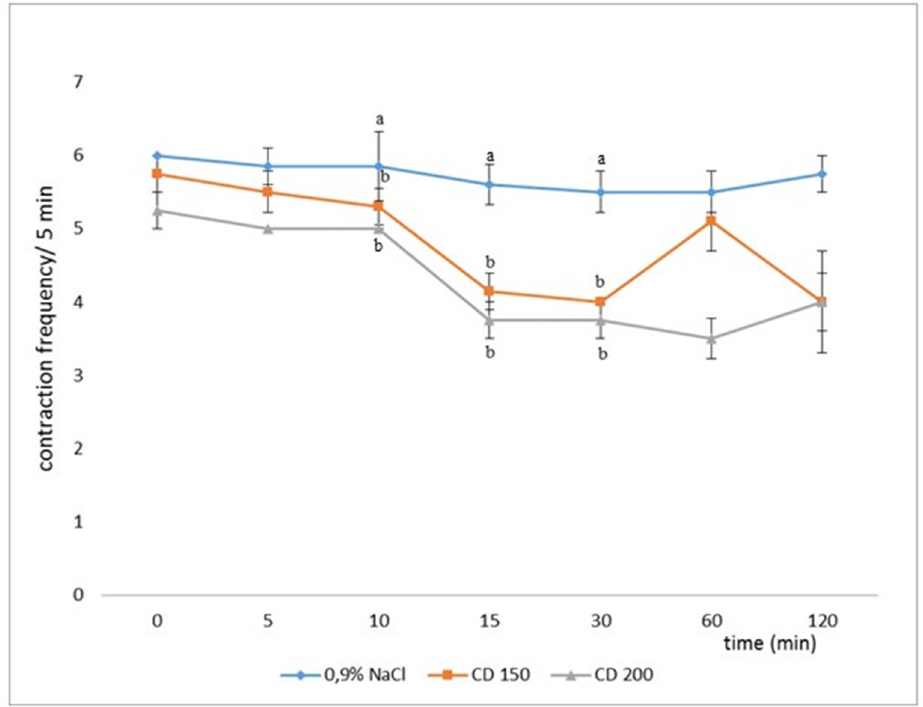
Figure 5. Effect of different degrees of 5 min colonic wall distension with 150 and/or 200 mL of water (CD150 and CD200) on the number of reticulo-rumen contractions before, during, and after 120 min CD in comparison to control (10 mL of 0.9% NaCl; n = 6 ± standard error of the mean (SEM)); a – statistically significant in relation to CD150, b – statistically significant in relation to control [18].